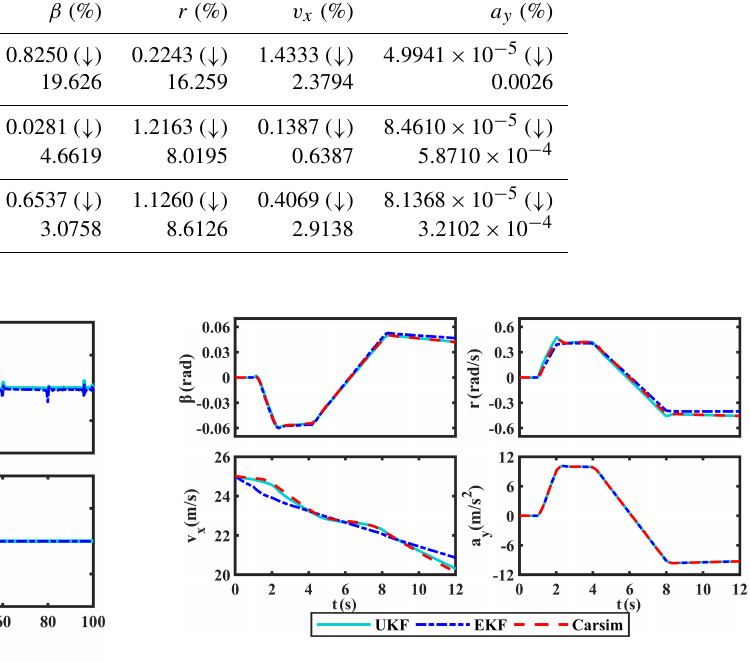
Figure 10. The estimated results of β , r , v x , and a y under fishhook manoeuver test I.